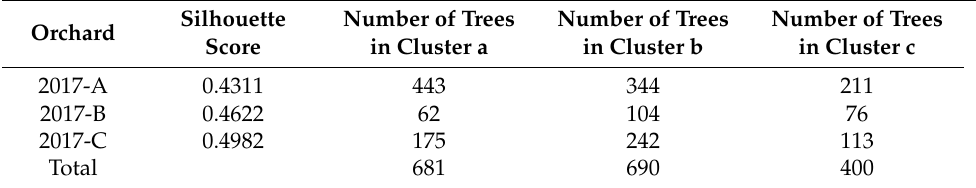
Table 3. Categorization of tree canopy images from each block into three clusters. Orchard